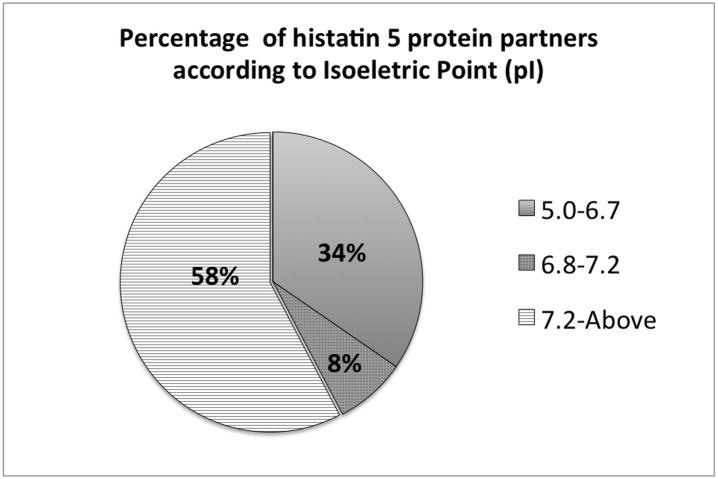
Percentage of histatin 5 protein partners according to Isoelectric Point (pI).The histatin 5 protein partners were divided according to the pI ranging from 5.0 to 6.7, 6.8 to 7.2 or above 7.2.